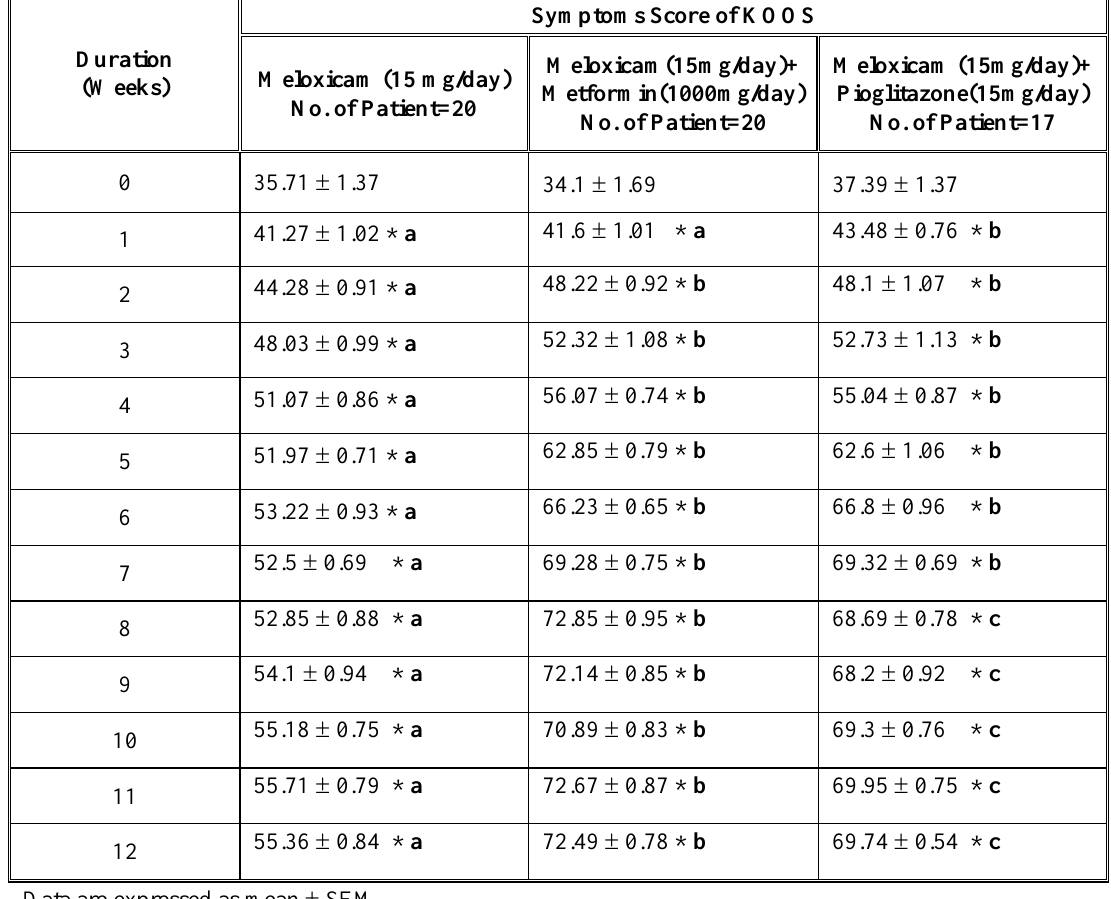
Table (2): Effects of treatment with meloxicam alone, combination of meloxicam + metformin, and meloxicam + pioglitazone on symptoms score in osteoarthritic